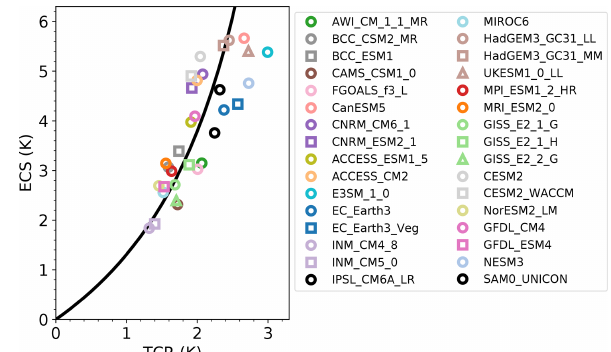
Figure 2. Scatter plot of TCR values plotted against ECS values for all CMIP6 models with both available at the time of submission. Models from the same modelling group are plotted with the same colour. Plot markers differentiate models from the same modelling centre. Black line uses the average ocean heat uptake parameters as fitted from the Geoffroy et al. (2013b) procedure, listed in Table S3, and related ECS and TCR via ECS = TCR / (1 − e (cid:48) TCR), with e (cid:48) = 0 . 24, the model